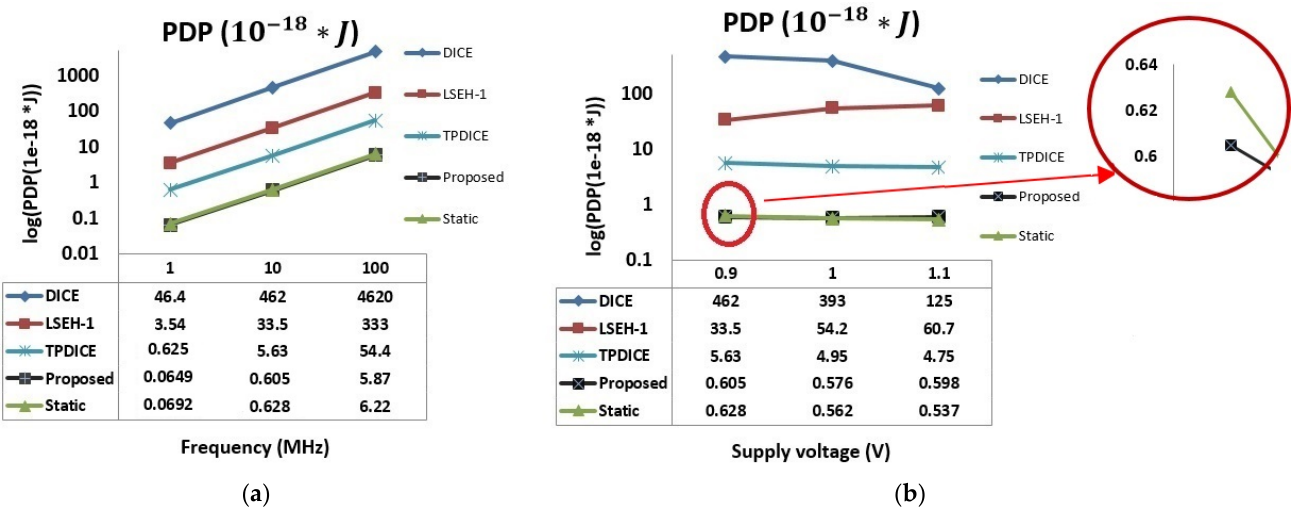
( b ) at three supply voltages and 10 MHz input frequency.